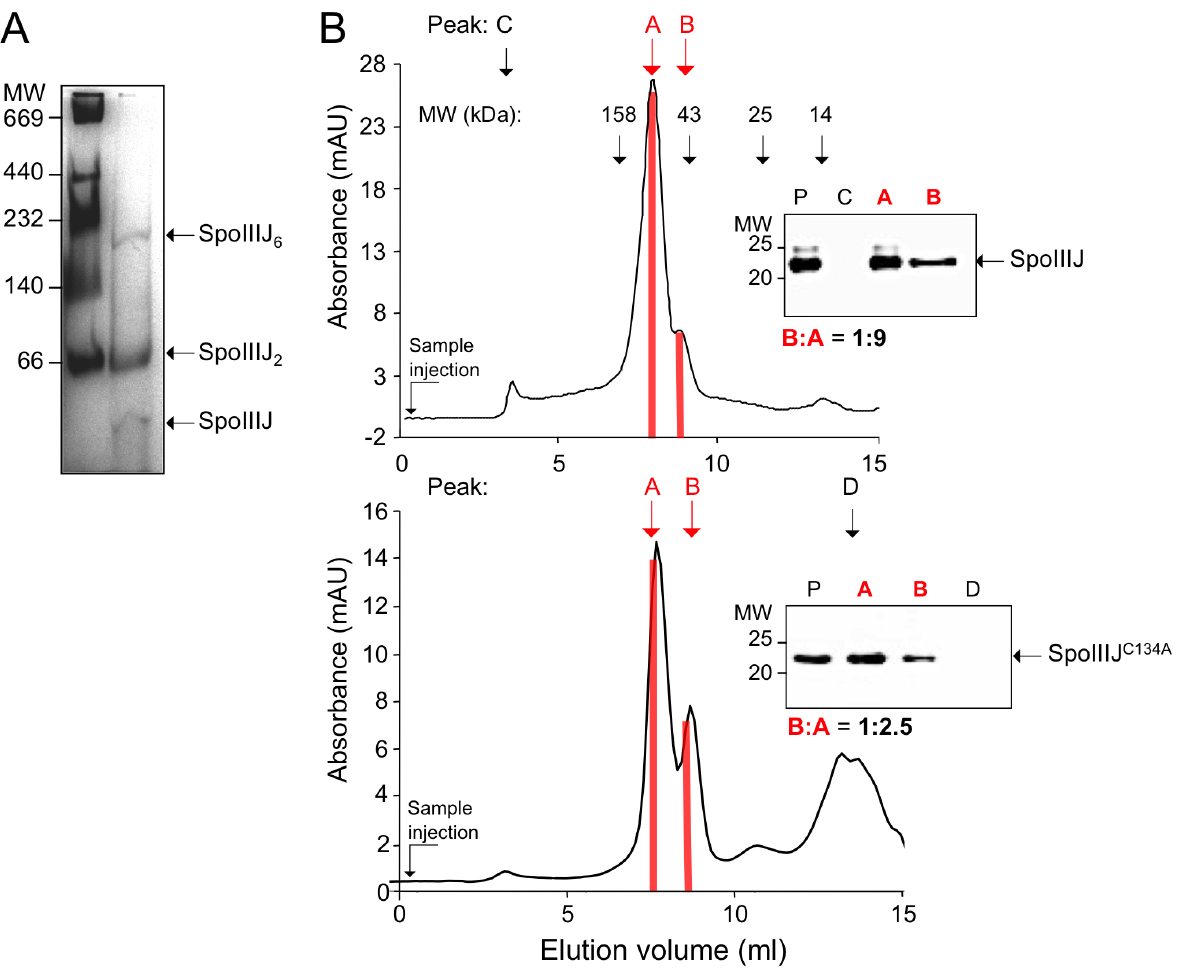
Figure 2. Oligomeric state of SpoIIIJ and SpoIIIJ C134A . (A) Blue-Native PAGE of purified SpoIIIJ-His 6 . Presumed hexameric (SpoIIIJ 6 ), dimeric (SpoIIIJ 2 ) and monomeric (SpoIIIJ) species are indicated. MW markers are shown in kDa. (B) Size exclusion chromatography of SpoIIIJ-His 6 (top) or SpoIIIJ C134A -His 6 (bottom) in the presence of 0.1% DDM and 500 mM NaCl at pH 7.6 (see the Material and Methods section for details). The vertical black arrows indicate the elution volumes of the size standards and additional peaks. The inserts show the immunoblot analysis of the peaks indicated in the two panels. Purified SpoIIIJ-His 6 (top) or SpoIIIJ C134A -His 6 (bottom) were included as a migration control (lane P). The areas of the A and B peaks in the two panels were estimated using the ImageJ software (http://imagej.nih.gov/ij/) and their ratio indicated.